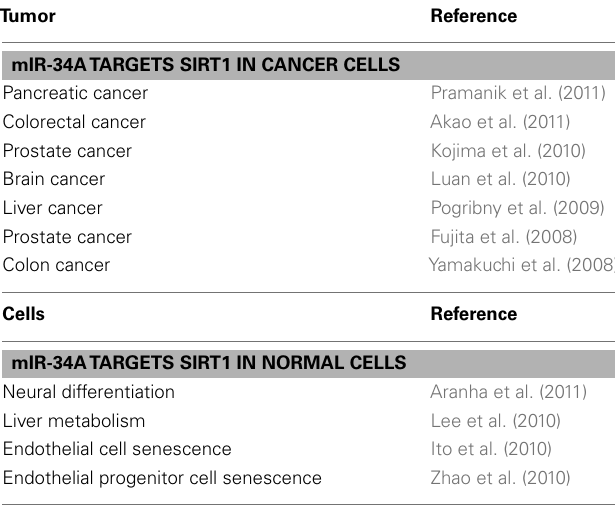
Table 1 | miR-34a targets